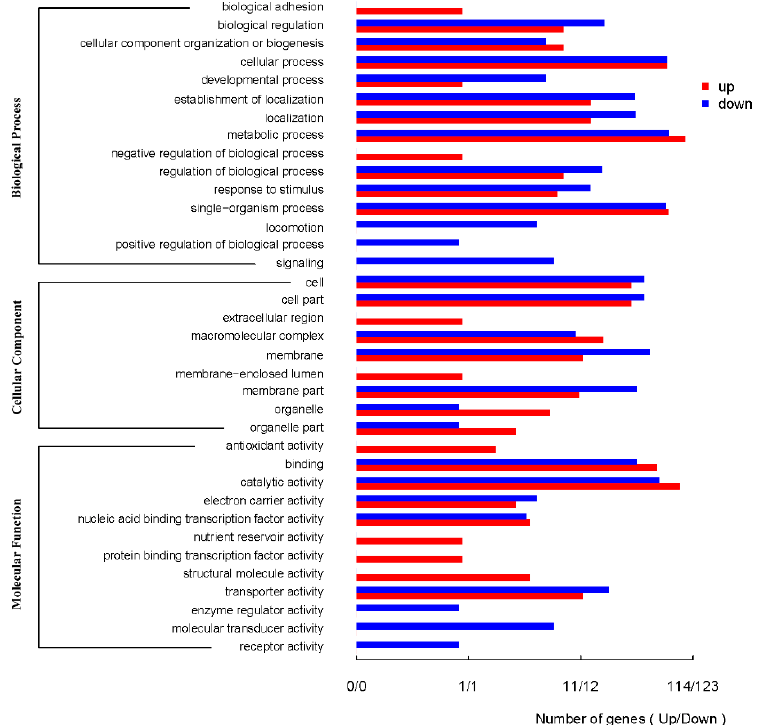
Figure 3. The GO annotations of differentially expressed genes of Bacillus atrophaeus ATCC 9372.